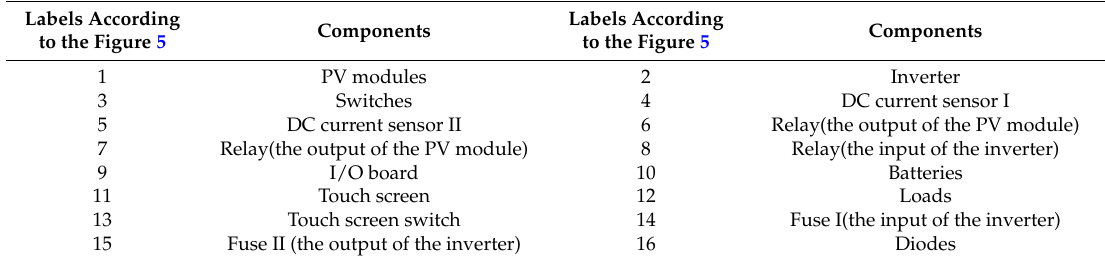
Table 4. The components according to the Figure 5.